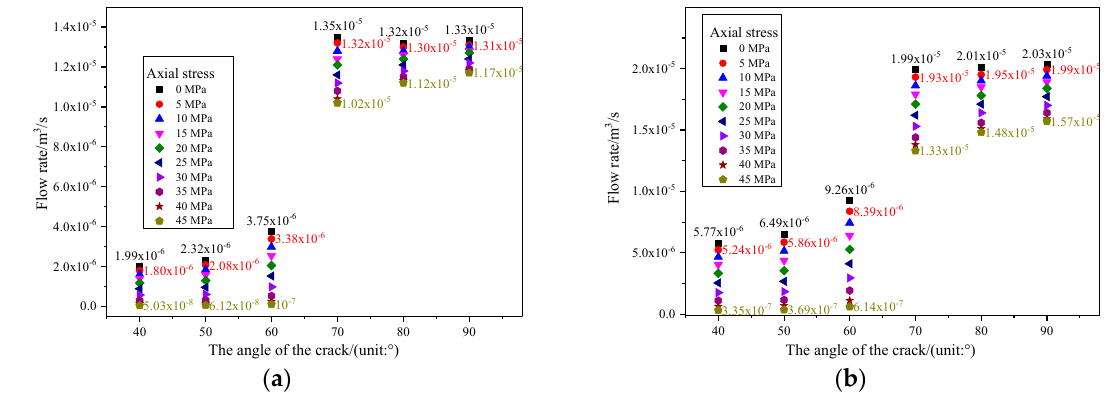
Figure 21. Flow rate change curves of different angles: ( a ) confining pressure of 20 MPa and ( b ) confining pressure of 10 MPa.